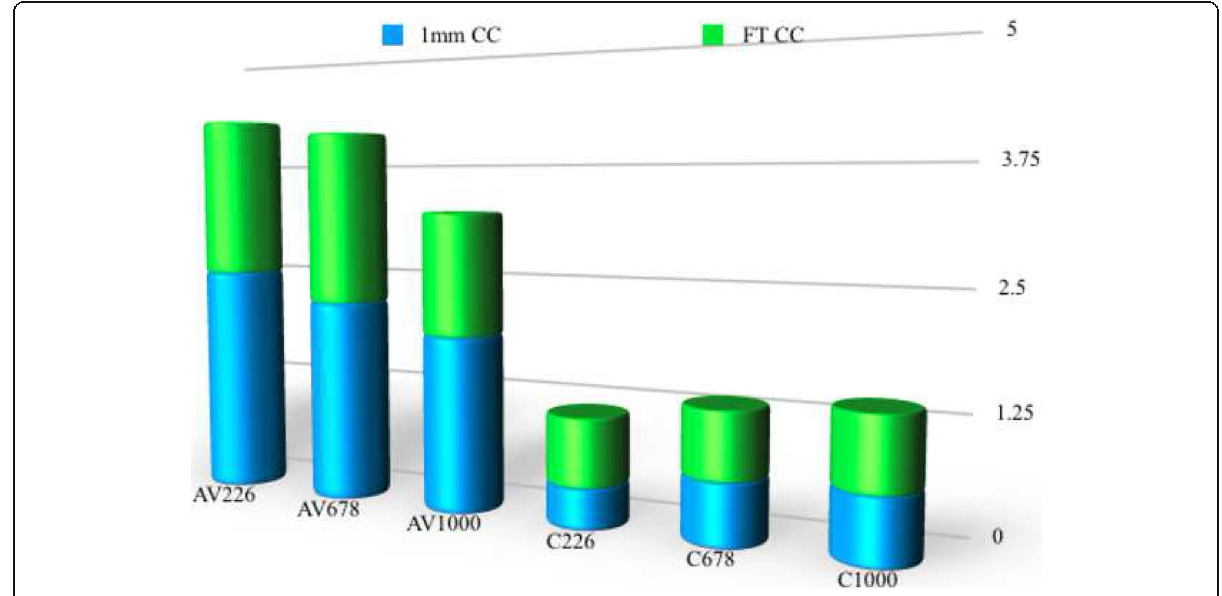
Fig. 5 Showing the tympanogram values containing air volume (AV) and compliance values